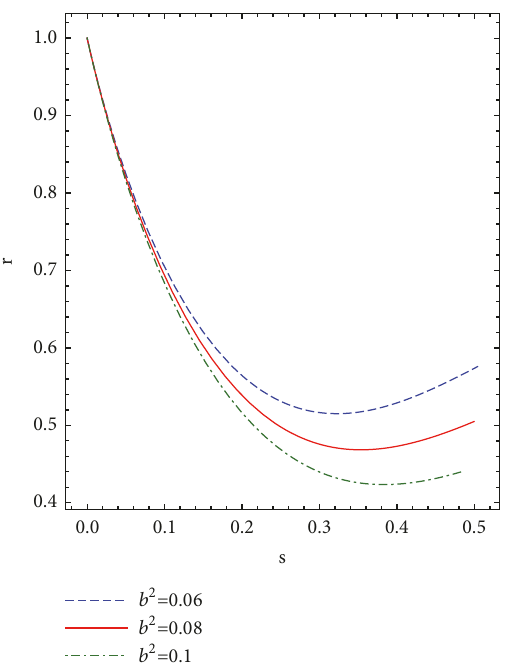
Figure 16: The evolution of the statefinder parameter 𝑟 versus 𝑠 for interacting GDE in the DGP model. Here, we have taken Ω 𝐷 (𝑧 = 0) = 0.73 , 𝐻(𝑧 = 0) = 67 , and Ω = .0003. 𝑟 𝑐